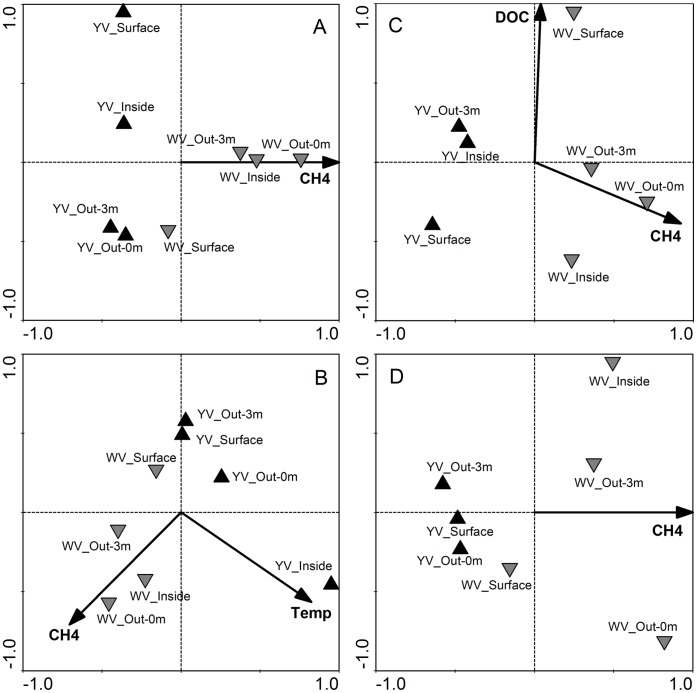
CCA (A, C and D) or RDA (B) analyses of bacterial or archaeal communities.(A) bacterial DNA-based libraries. (B) bacterial RNA-based libraries. (C) archaeal DNA-based libraries. (D) archaeal RNA-based libraries. Each point represents an individual sample. Arrowheads represent statistically significant environmental variables explaining the observed patterns (P = 0.002). CH4: methane. Temp: temperature. DOC: dissolved organic carbon.